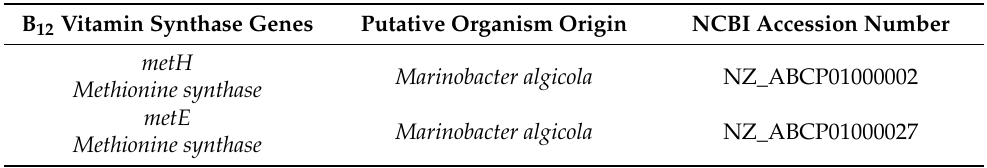
Figure 2. O. tauri RCC4221 growth in coculture with M. algicola OT MT023716. Cocultures were performed in complete ESAW- F/2 medium (solid curves) and in ESAW medium depleted in vitamin B 12 (ESAW minus B 12 ) medium (dotted curves). Table 1. BWA alignment results of vitamin B 12 synthase genes with raw genomics reads from 19 O. tauri (and its phycosphere) line cultures. From these 19 independent lines, which were endpoints diluted through serial subcultures [41], all the cultivable bacteria in solid media were determined to be M. algicola OT MT023716